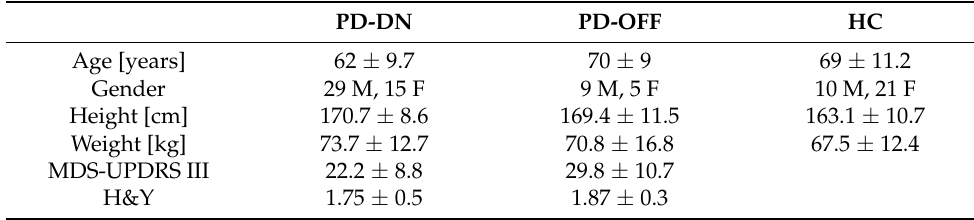
Table 1. Clinical and demographic features of the